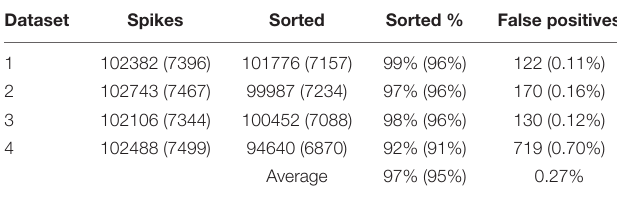
TABLE 3 | The results of applying our method to the simulated tetrode datasets.